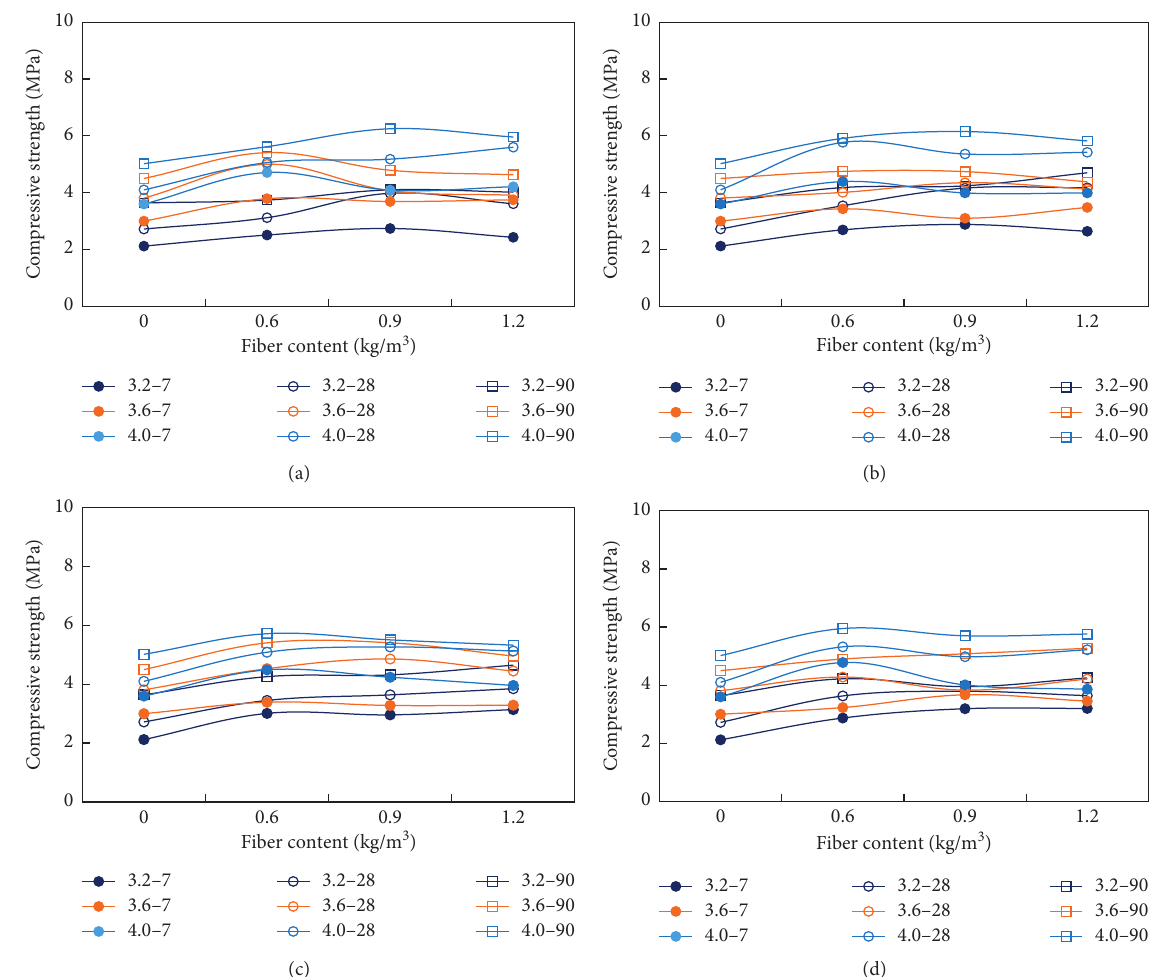
Figure 10: Trend chart of UCS of CSM with different fiber contents: (a) fiber length of 12mm, (b) fiber length of 18mm, (c) fiber length of 24mm, and (d) fiber length of